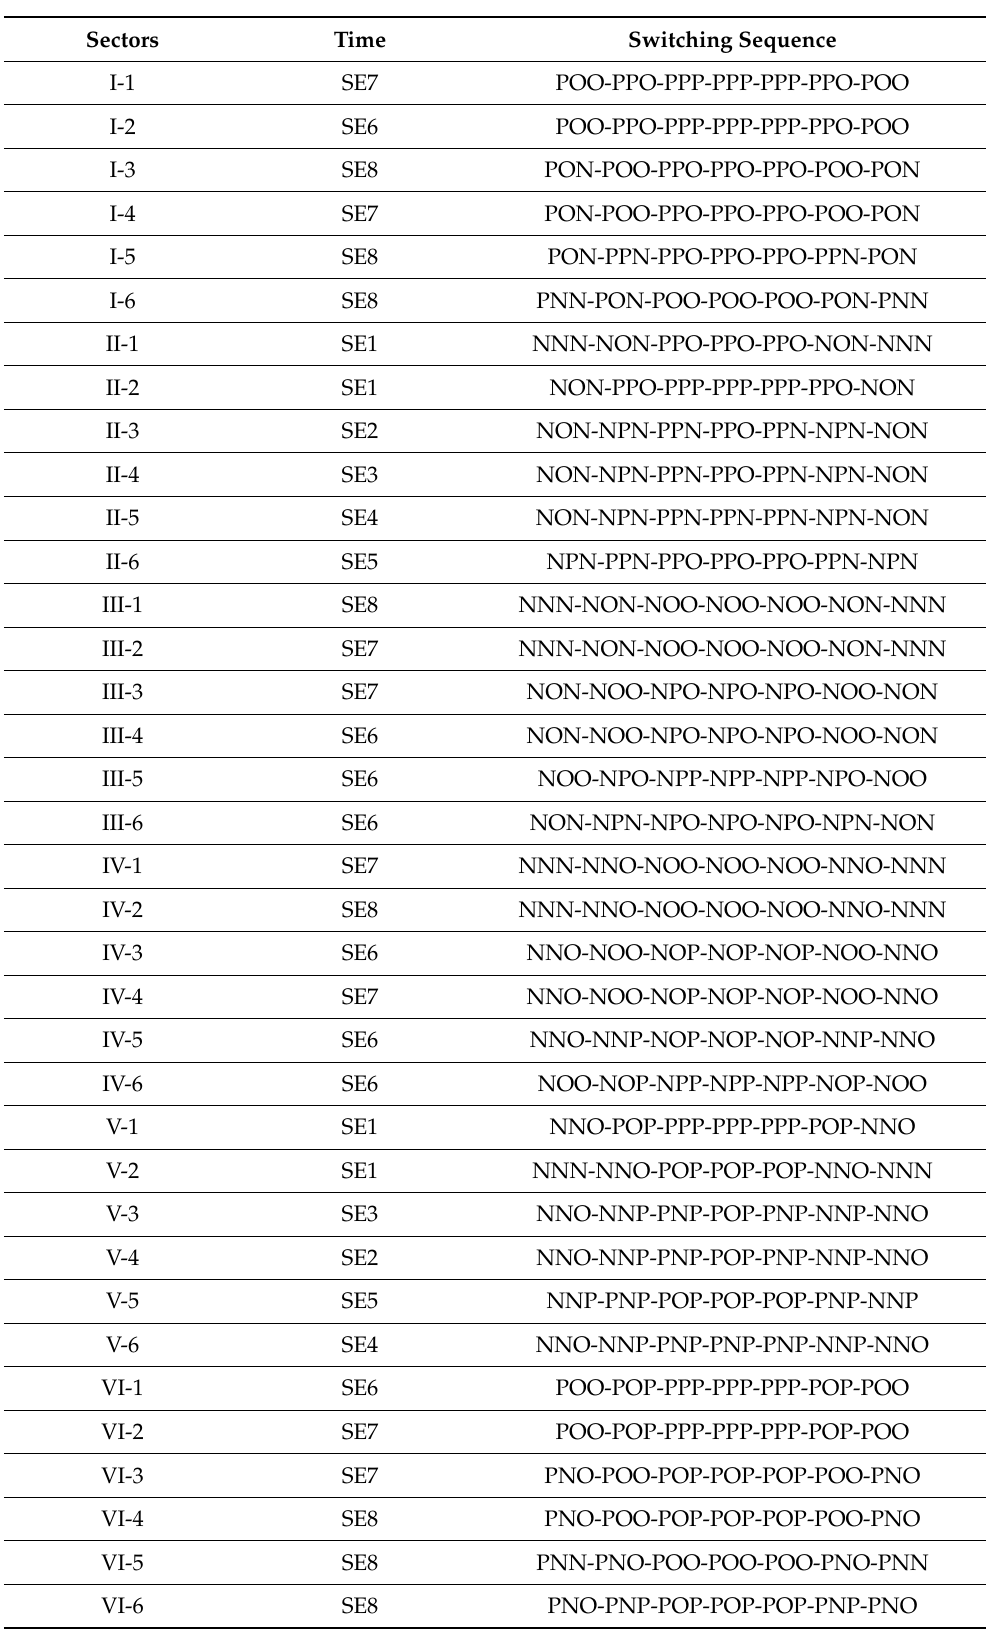
Table 2. The sequence and action time of